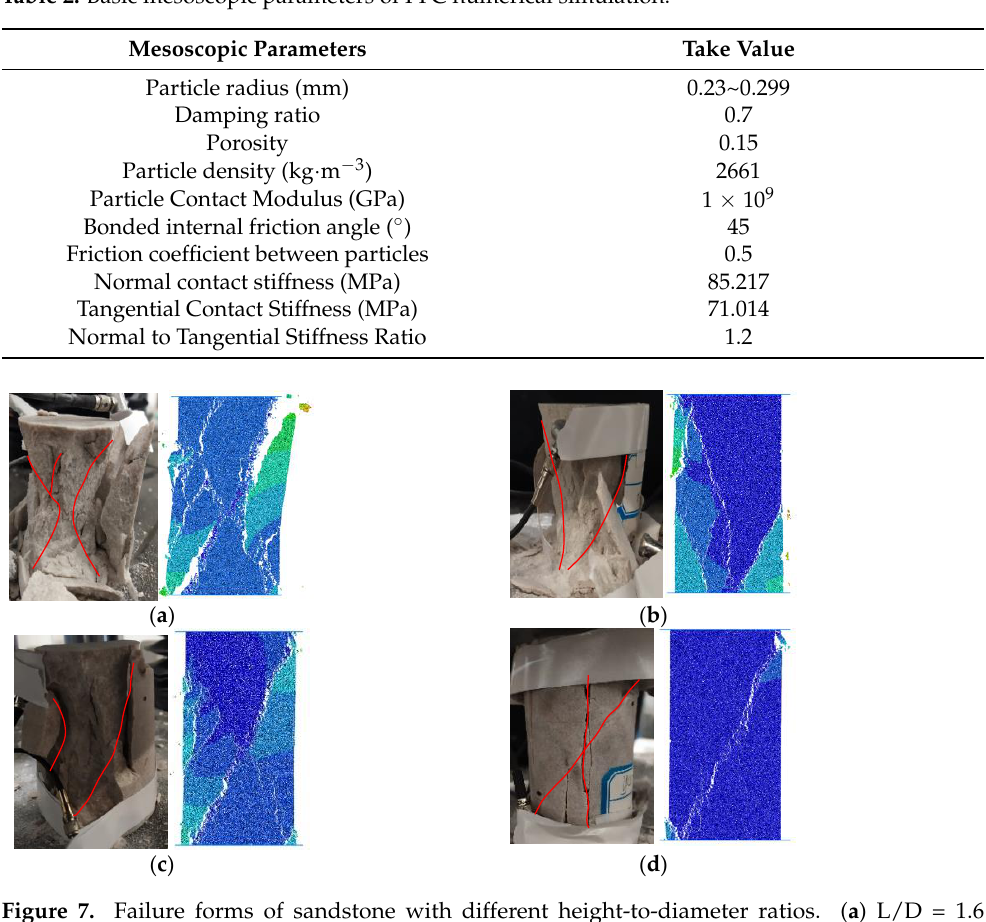
Figure 6. PFC 2D model and loading diagram. Table 2. Basic mesoscopic parameters of PFC numerical simulation.